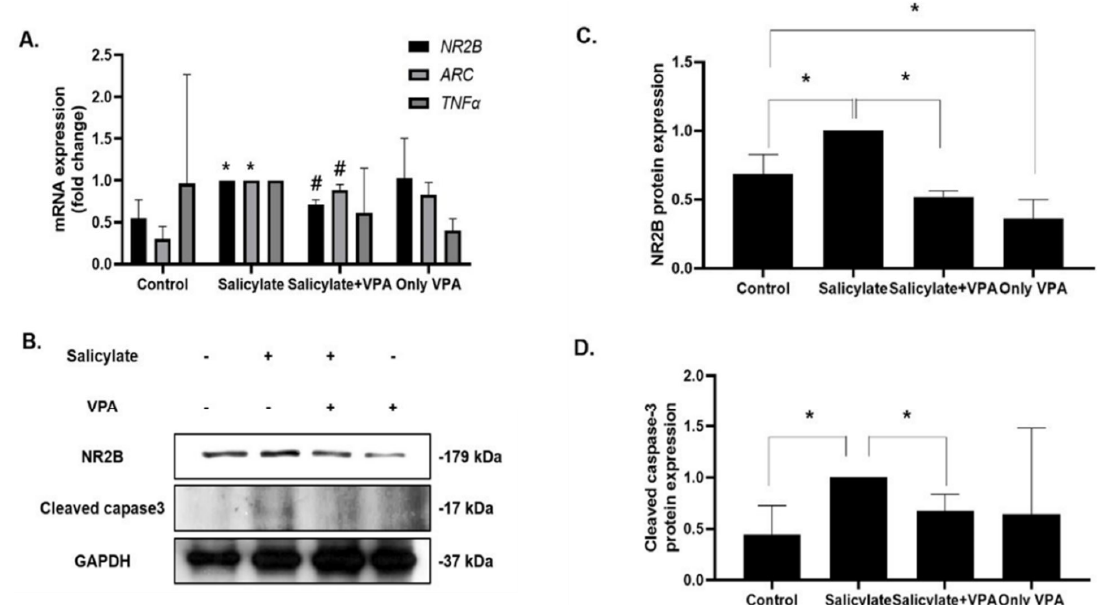
Figure 4. Effect of VPA in rat cortical neurons ( A ) The gene expression levels of NR2B, TNF α , and ARC were increased with salicylate treatment and decreased in VPA-treated rat cortical neurons (* p < 0.05, # p < 0.05, mean ± SD, n = 3). ( B ) The protein expression levels of NR2B (( C ); * p < 0.05, mean ± SD, n = 3) and cleaved caspase-3 (( D ); * p < 0.05, mean ± SD, n = 4) were measured using immunoblot analysis, quantified using the Image J software, and normalized with those of GAPDH. One-way ANOVA followed by post hoc Tukey test using GraphPad Prism